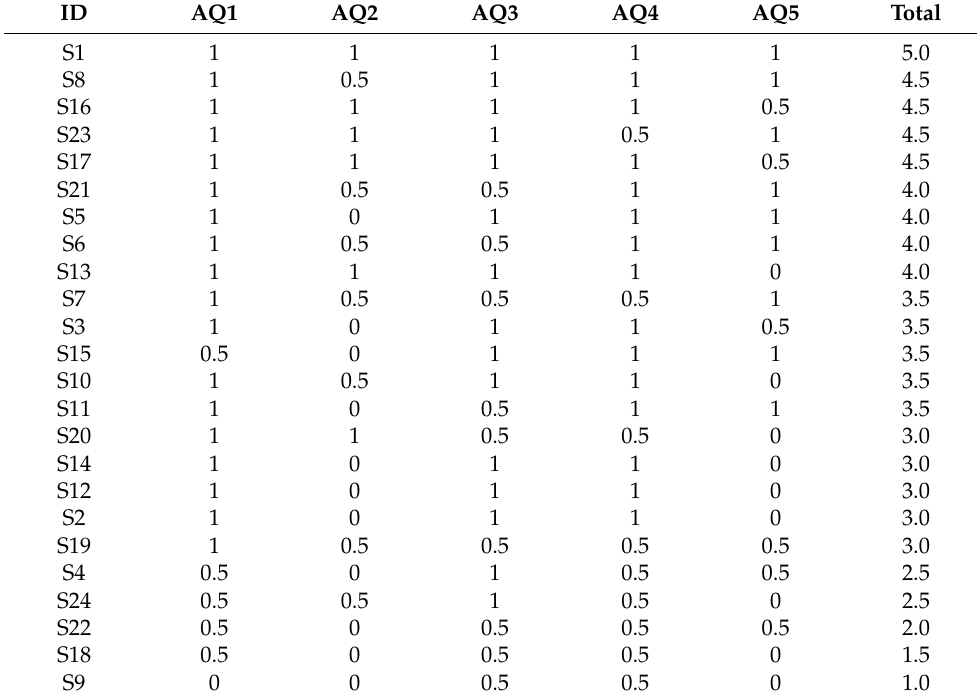
Table 2. Ranking of scores according to Quality Assessments.